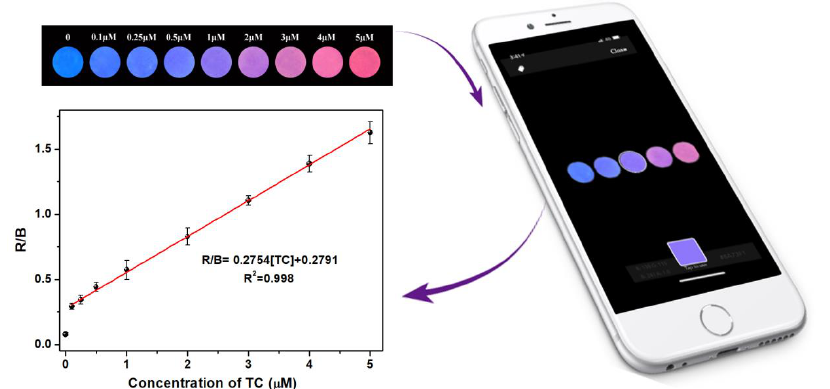
Figure 7. Fluorescence color images the SiCDs@mMIP-cit-Eu immobilized test paper at the different TC concentrations under a 365 nm UV lamp, and the corresponding relationship between TC concentrations and color ratio (R/B) achieved by a smartphone color-scanning APP.